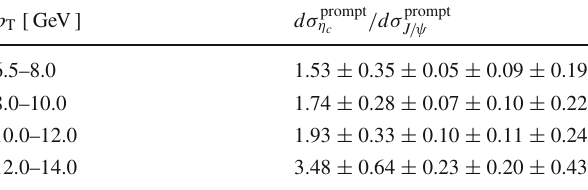
Table 5 Relative p T -differential η c prompt production cross-section